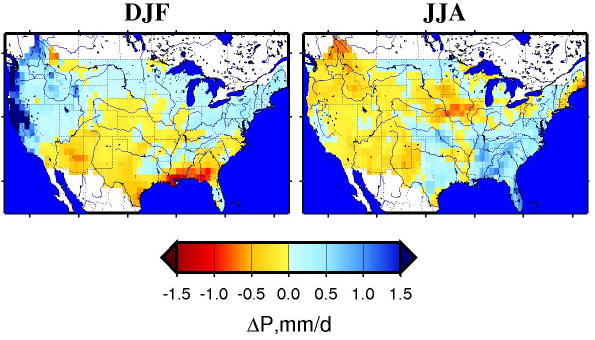
Fig. 7. Difference between observed seasonal mean precipitation